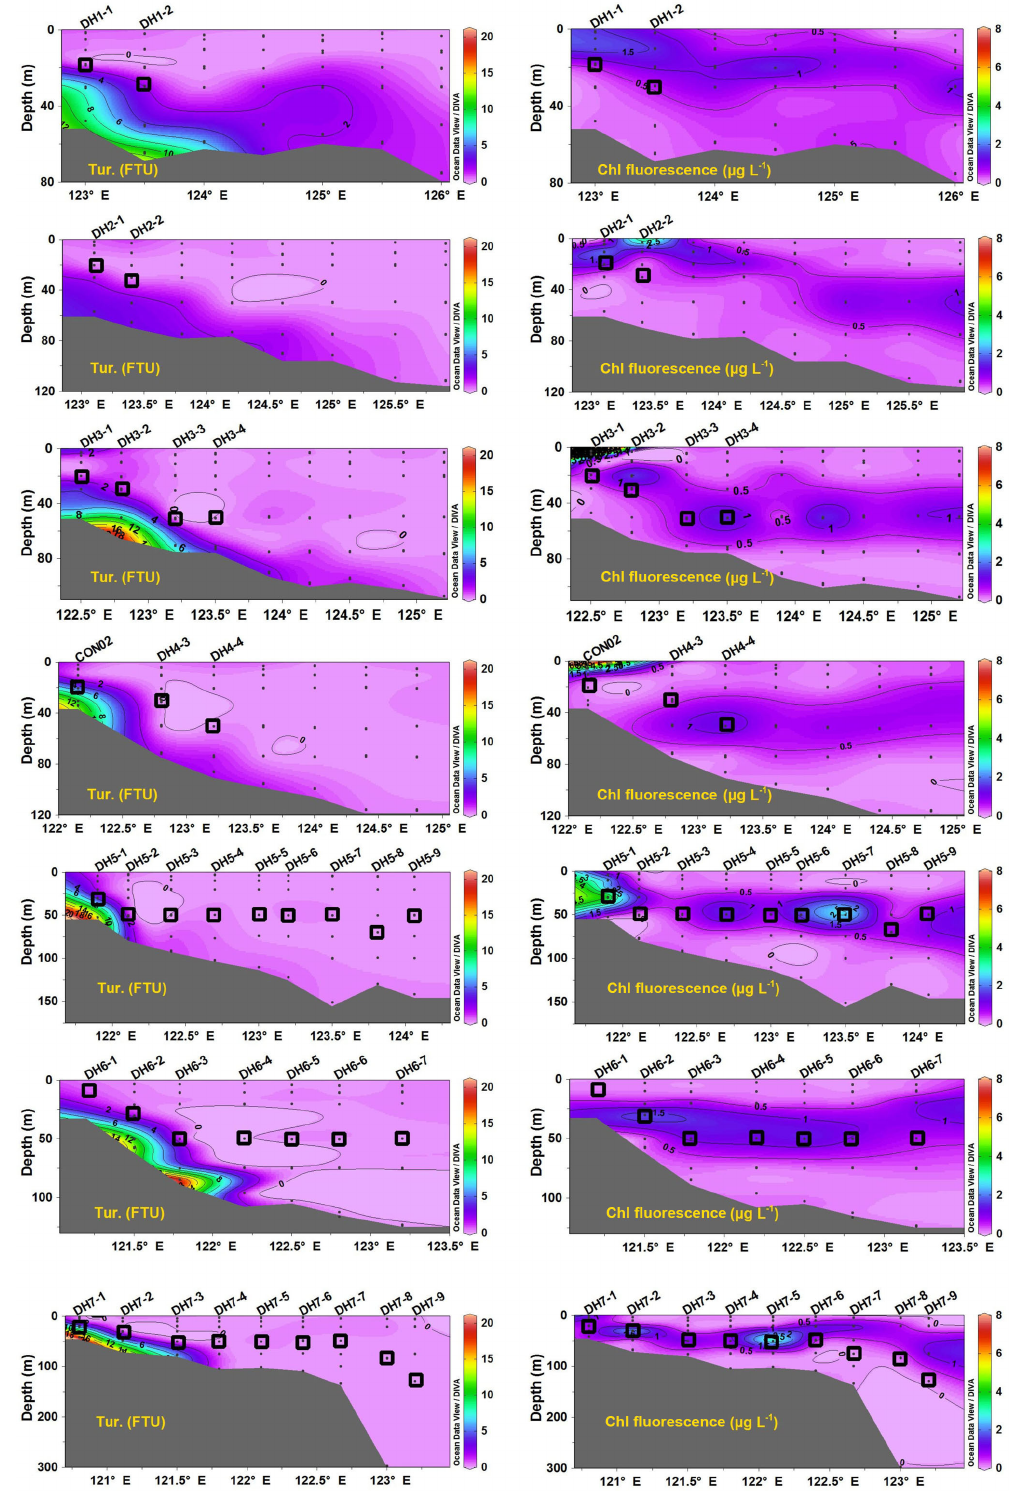
Figure 3. Vertical distributions of turbidity (Tur.) and chlorophyll fluorescence (Chl fluorescence) concentration along seven cross-shelf transects in the southern East China Sea during summer